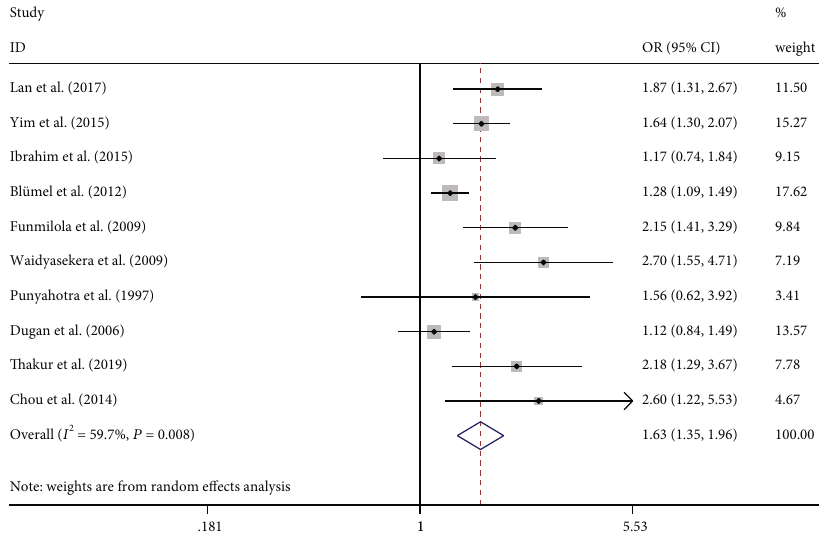
Figure 3: Meta-analysis of the estimated MSP prevalence between premenopausal and perimenopausal women. Ten studies were included in the analysis. OR (95% CI): odds ratio (95% con fi dence